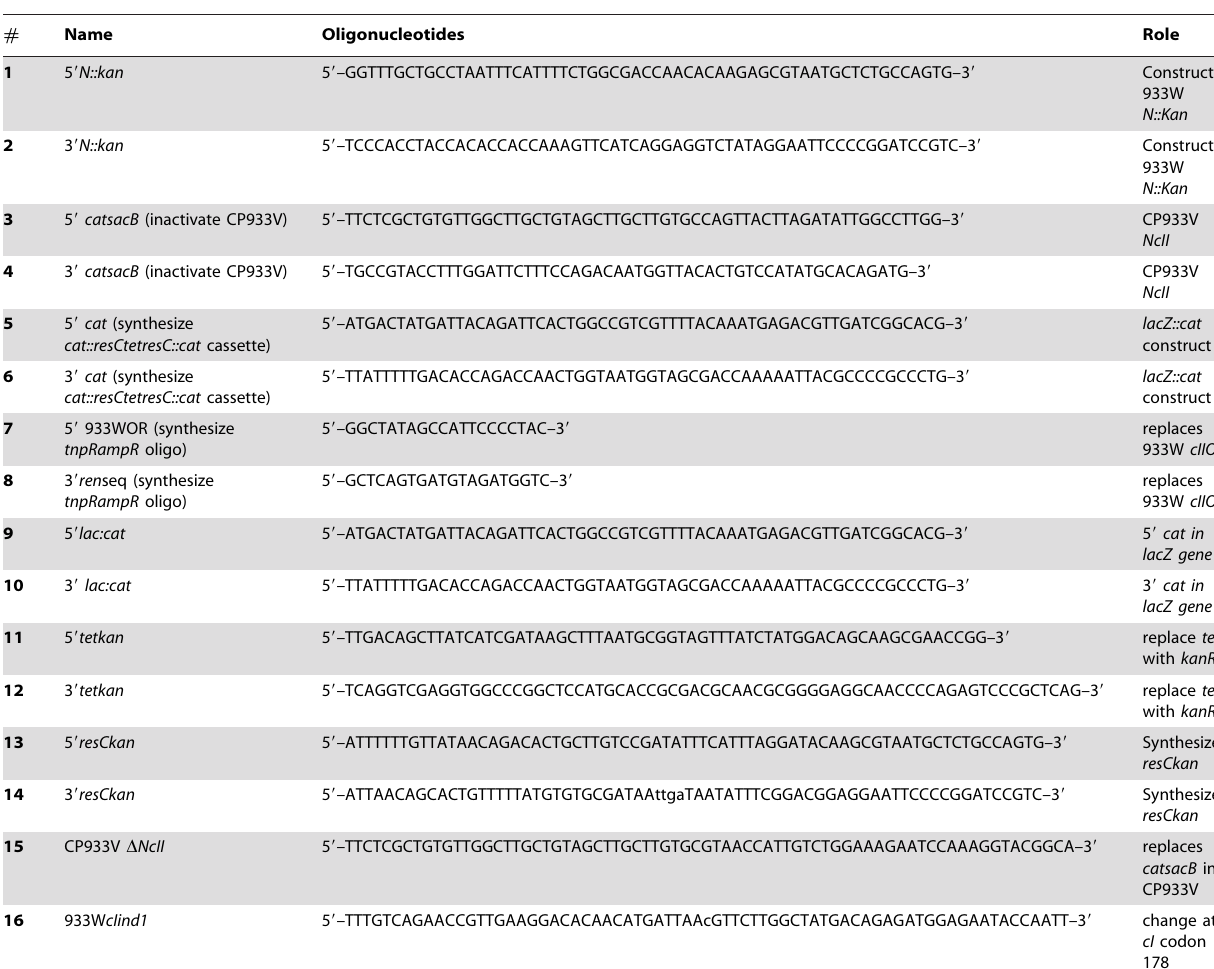
Table 2. Primers and